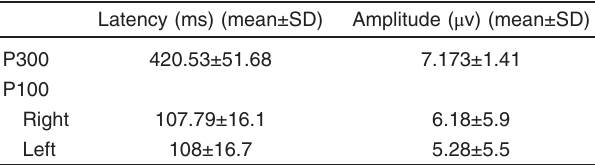
Table 3 Mean±SD of auditory P300 and visual P100 peak latencies and amplitude